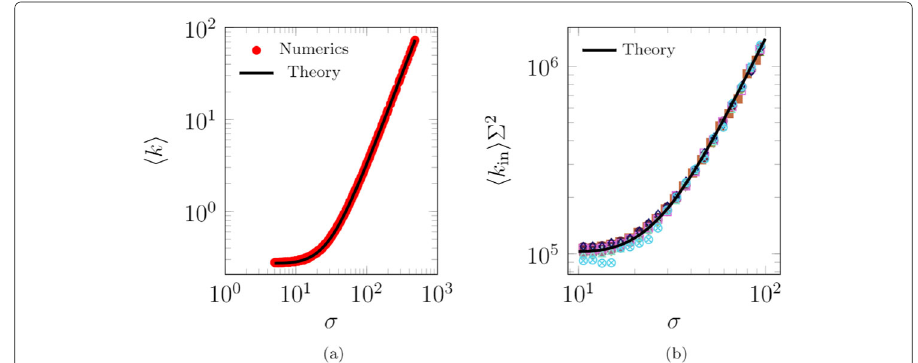
Fig. 3 Relationship between the agents’ average degree and radius of interaction. a Comparison between numerical results and analytical predictions from Eq. (8), for the case without base locations. Simulation results are generated with the following parameter set: L = 0, D = 100,000, σ min = 5, and σ max = 500. For each value of σ i , Eq. (8) provides the expected degree, which is numerically estimated by tracking the corresponding agent in time. b Comparison between numerical results and analytical predictions from Eq. (9), in the case of multiple base locations, uniformly distributed in the plane. For each value of σ i and (cid:6) β( i ) , Eq. (9) provides the expected degree, which is numerically estimated by tracking the corresponding agent in time. Numerical results are presented using different colors and markers, corresponding to each of the locations (numerical findings share a common trend, which is well captured by the theory). In the simulations, we use the following parameters: L = 10, D = 10 9 , (cid:6) min = 1,000, (cid:6) max = 10,000, σ min = 10, = 100, p = 0.3, and α = 0. Agents are initially inside their base location and interactions are recorded σ max after 100 steps to allow agents to reach a steady-state configuration. Other parameter values are N = 10,000, v = 500, c = 4 · 10 − 4 , ω = 2.4, γ = 2.1, and T =